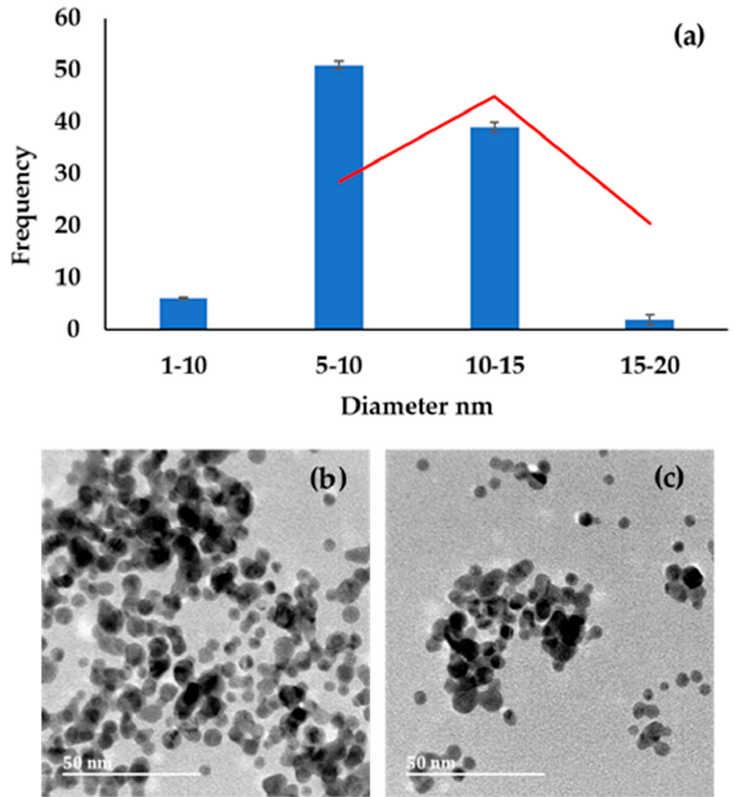
Figure 3. ( a ) Histogram obtained by measuring the diameter of AuNPs; ( b , c ) HRTEM images of ascorbic acid AuNPs . The synthesized TSC ‐ AuNPs have spherical and irregular shapes, with an average size of 27 nm (Figure 4). AuNPs synthesized with the reducing agent tri ‐ sodium citrate (TSC ‐ AuNPs) resulted in nanoparticles with a particle size dimension of above 20 nm [31,32]. The TSC ‐ AuNPs were analyzed using HRTEM, and the results are presented in Figure 4b,c. Sodium borohydride (NaBH 4 ) and ascorbic acid ‐ reduced AuNPs were combined and left at room temperature they grew to a diameter of more than 20 nm. This resulting solu ‐ tion of NPs was sonicated for longer than other synthesized AuNPs, because of the ob ‐ served agglomeration. The shapes of the AuNPs were found to have an average size of 75 nm, with spherical, triangular, and rhombic shapes, while some were irregular (Figure 5). This could be because controlling shape of nanoparticles synthesized by the seed growth method is generally difficult. AuNPs with a particle size greater than 50 nm (NaBH 4 ‐ ASCB ‐ AuNPs) were synthesized using the seed growth method [33,34].